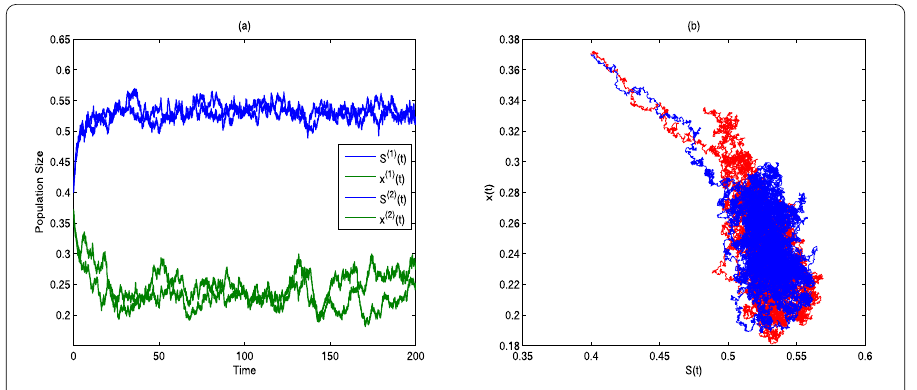
Figure 2 The time series and portrait phase of model (4.1) when α = 0.3 ( S (1) ( t ) and S (2) ( t ) are two sample paths about S ( t ), x (1) ( t ) and x (2) ( t ) are two sample paths about x ( t ).) ( a ) represents the time series of S ( t ) and x ( t ); ( b ) represents the portrait phase.